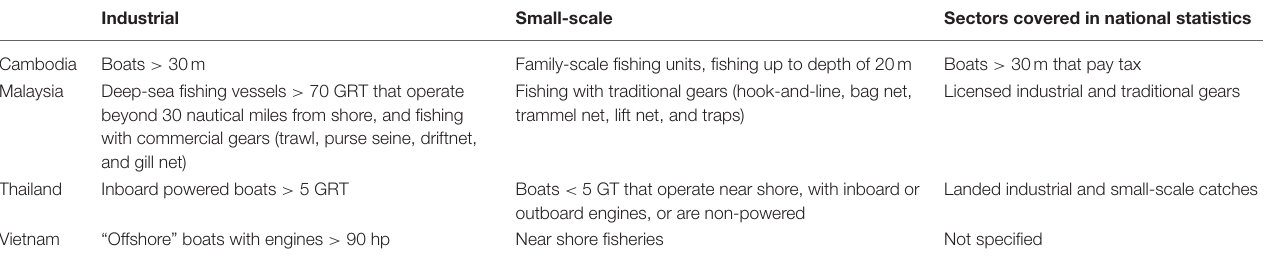
TABLE 1 | Description of fisheries that are considered industrial and small-scale in each of the four studied countries, and their coverage in national fisheries statistics.